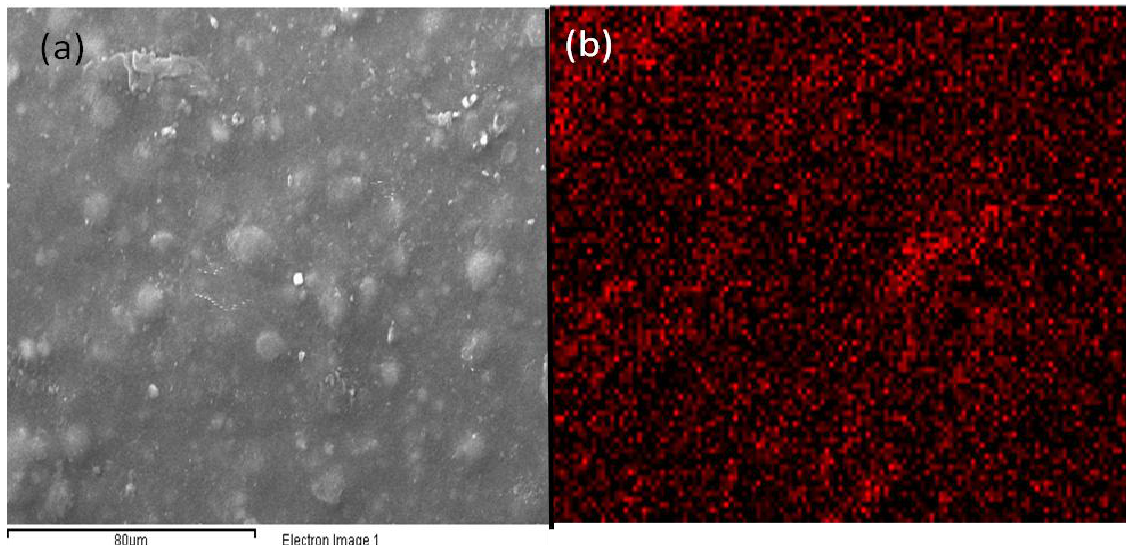
Figure 5. ( a ) SEM of aqueous TiO electron emission of the same